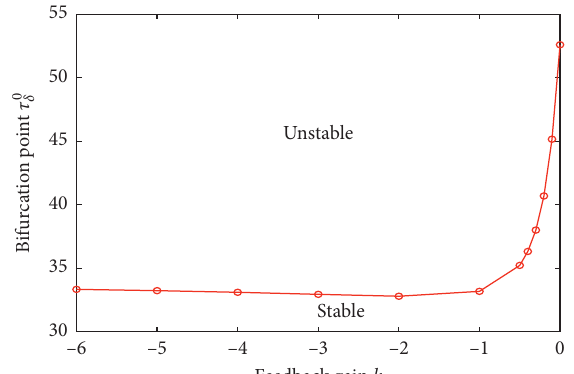
Figure 9: The impact of the feedback gain k on the bifurcation value τ 0